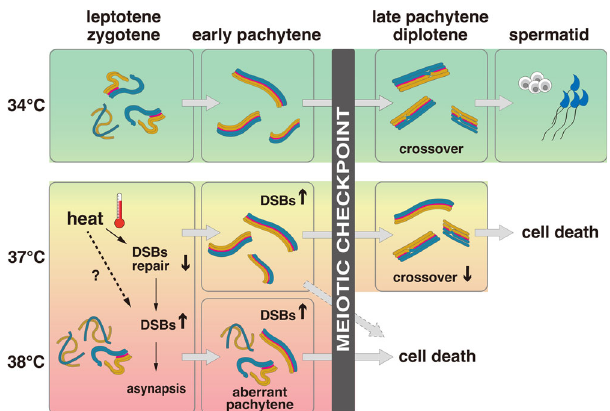
Fig. 8 Schematic representation of the impact of temperature on mouse meiosis. At 34 °C, meiosis is completed leading to spermatid formation. At high temperatures (37 °C or 38 °C), DNA double-strand breaks (DBSs) increased, at least in part, due to defective DSB repair, leading to increased asynapsis. Heat may also increase the DSB genesis. The degree of impairment varies between cells, with severely affected cells falling into a state of aberrant pachytene and less-affected cells completing chromosome pairing. The meiotic checkpoint then surveys the DSBs and asynapsis in these cells. Cells with DSBs and asynapsis above the threshold (including aberrant pachytene and probably some fully synapsed early pachytene) are eliminated through apoptotic cell death; those below the threshold survive to late pachytene. All cells are eliminated at the meiotic checkpoint at 38 °C, whereas some survived to late pachytene at 37 °C. However, late pachytene spermatocytes surviving at 37 °C retain abnormally abundant DSBs and asynapsis, leading to compromised crossover formation and cell death without completing meiotic